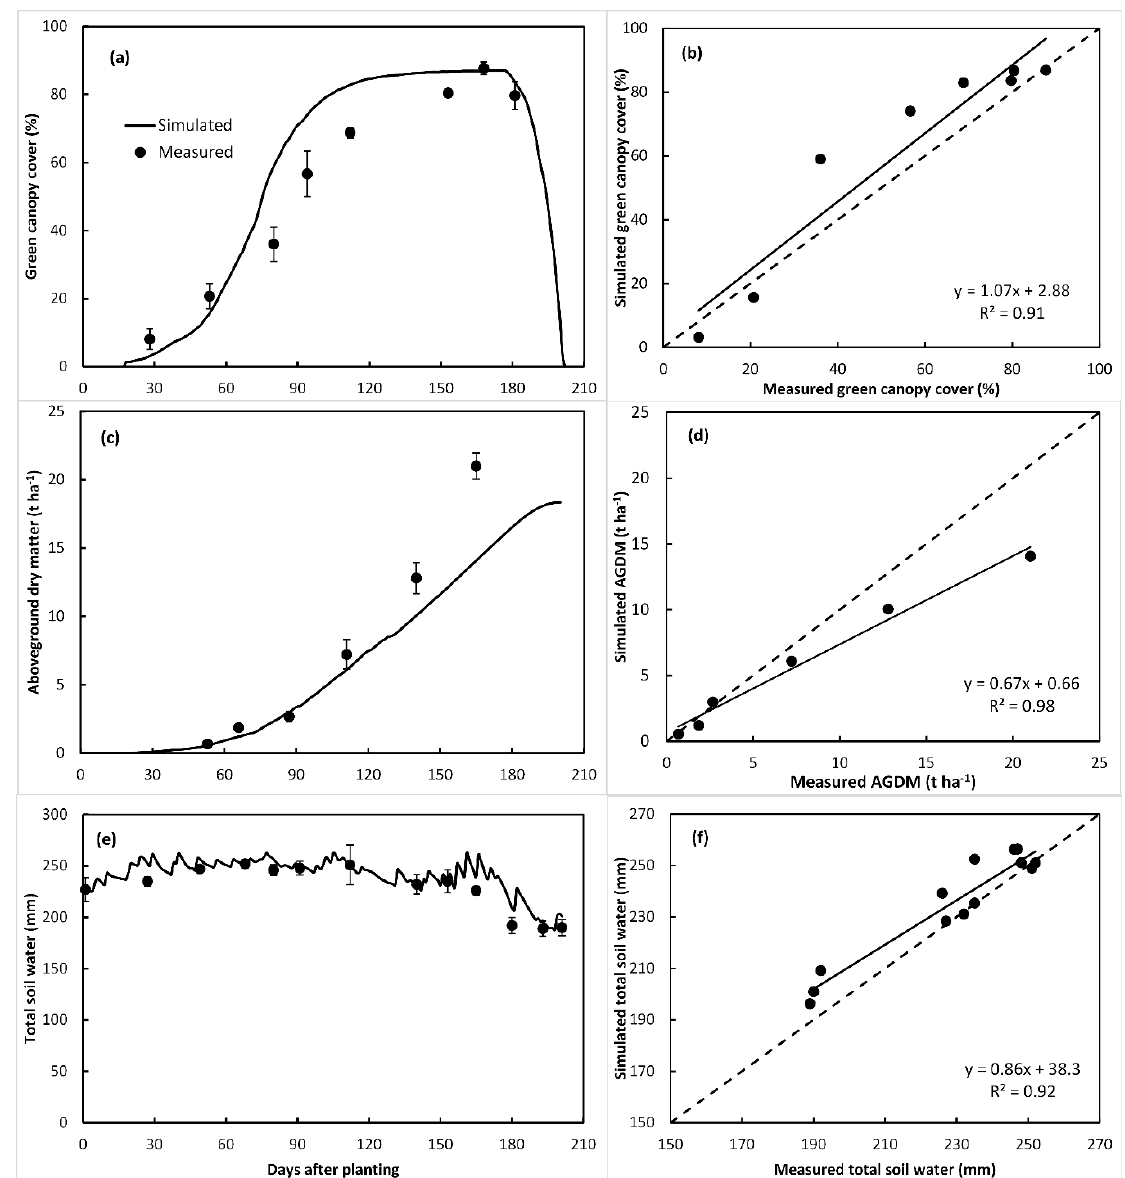
Figure 3. The evolution of measured and simulated values of crop canopy cover (CC), above-ground dry matter (AGDM), and total soil water (TSW) of 120 cm soil profile for the calibration treatment. Regression of measured data and simulated results and distribution of measured values about 1:1 line are also shown. ( a ) Measured and simulated CC during the growing season; ( b ) regression of measured and simulated CC; ( c ) measured and simulated AGDM during the growing season; ( d ) regression of measured and simulated AGDM; ( e ) measured and simulated TSW during the growing season; ( f ) regression of measured and simulated TSW. Table 4. AquaCrop calibration parameters and their respective values for faba bean (cv. Samira).